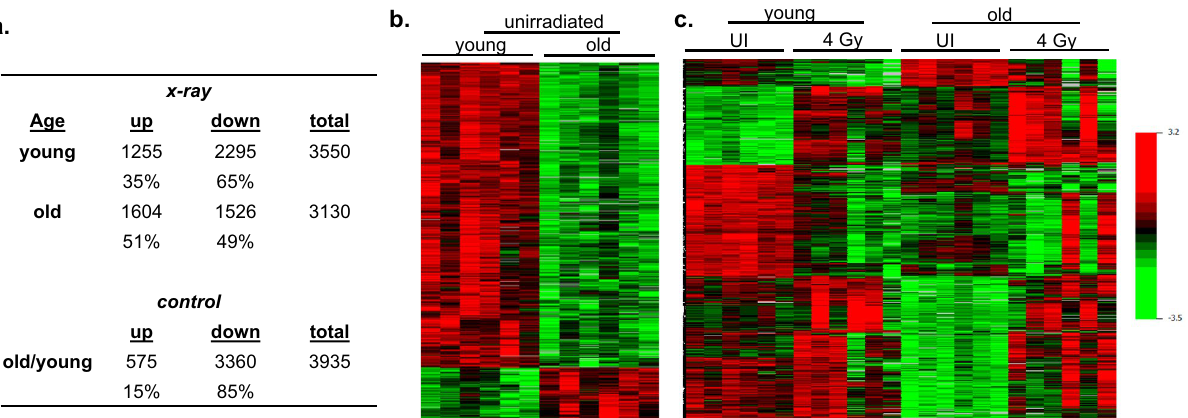
Figure 2. Differentially expressed genes. ( a ) Significantly differentially expressed genes in young and old mouse blood ( p < 0.005) after 4 Gy x-rays ( x-ray ) relative to unirradiated mice and under basal conditions comparing old versus young mice ( control ). Percent of upregulated ( up ) and down-regulated ( down ) genes are shown. ( b ) Heatmap of gene expression changes between young and old mice under homeostatic conditions. ( c ) Heatmap depicting relative gene expression of age-related genes from ( b ) that respond significantly to irradiation. Red indicates high expression, green indicates low expression as indicated in the color key. Each row represents one gene and each column represents an individual mouse, ordered by exposure dose and age group as labeled in the figure. UI